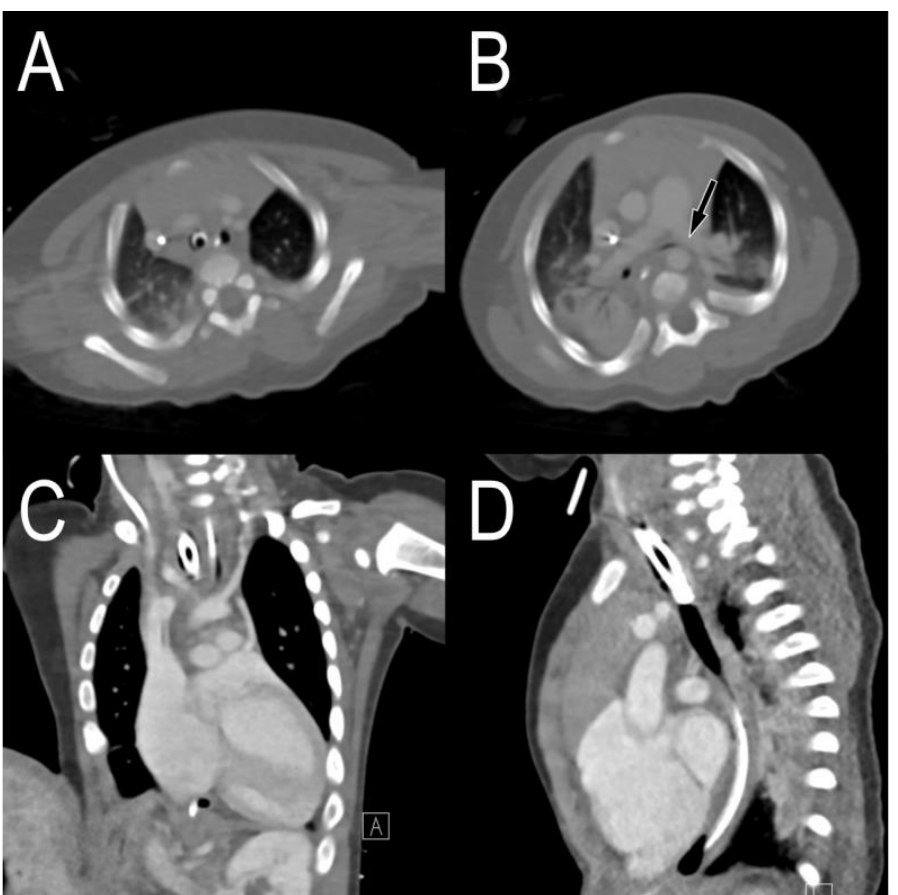
Figure 3. Chest computed tomography images before tracheostomy. ( A ) The axial view shows that the trachea and innominate artery are adjacent, and ( B ) the left main bronchus is compressed by the left pulmonary artery. In ( C ) coronal and ( D ) sagittal views, the cannula tip is attached to the innominate artery.